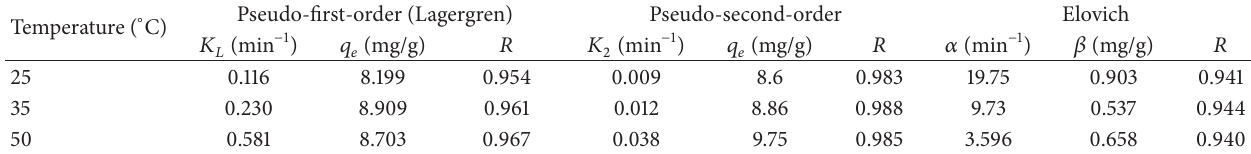
Table 1: Kinetic parameters of cadmium sorption by calcium alginate beads at different temperatures. Temperature ( ∘ C)